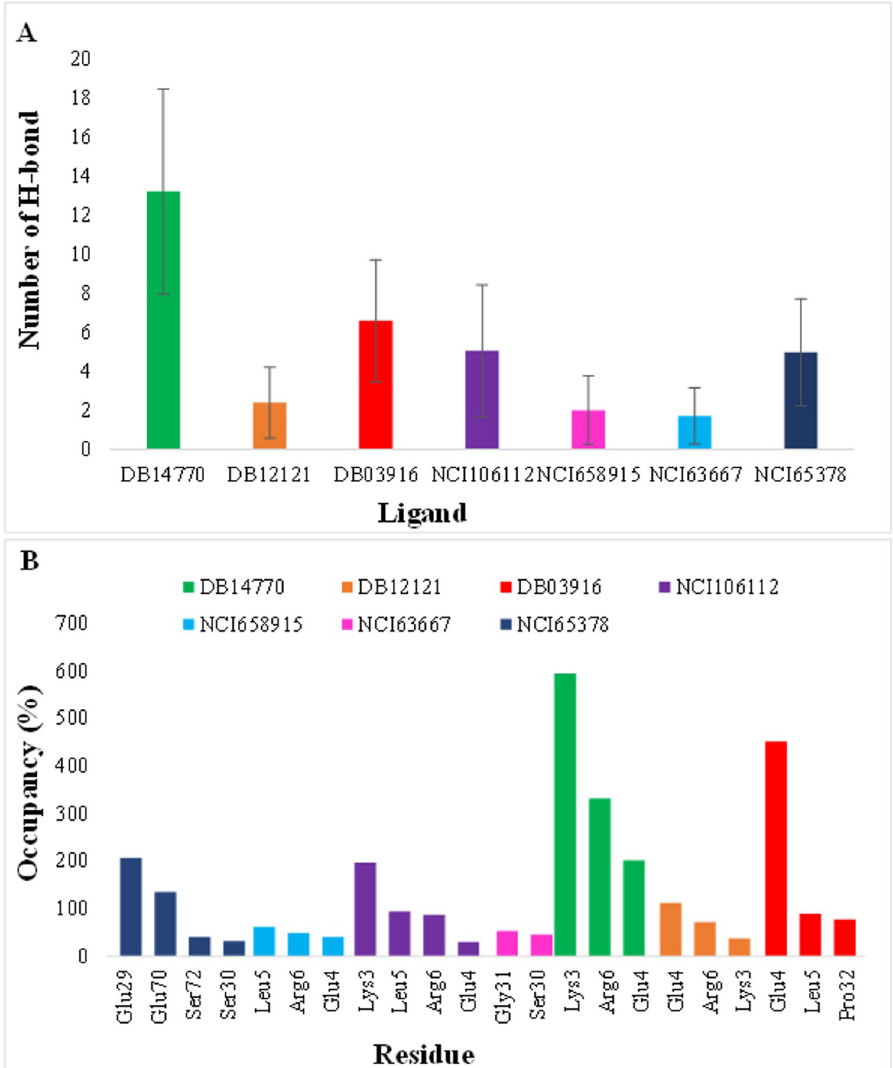
Fig 5. The hydrogen bond H-bond analysis. (A) H-bond average values of seven investigated compounds. (B) Hydrogen bond occupancy of 7 ligands by residues in 50 ns simulations trajectories, only interactions with a frequency greater than 30% were